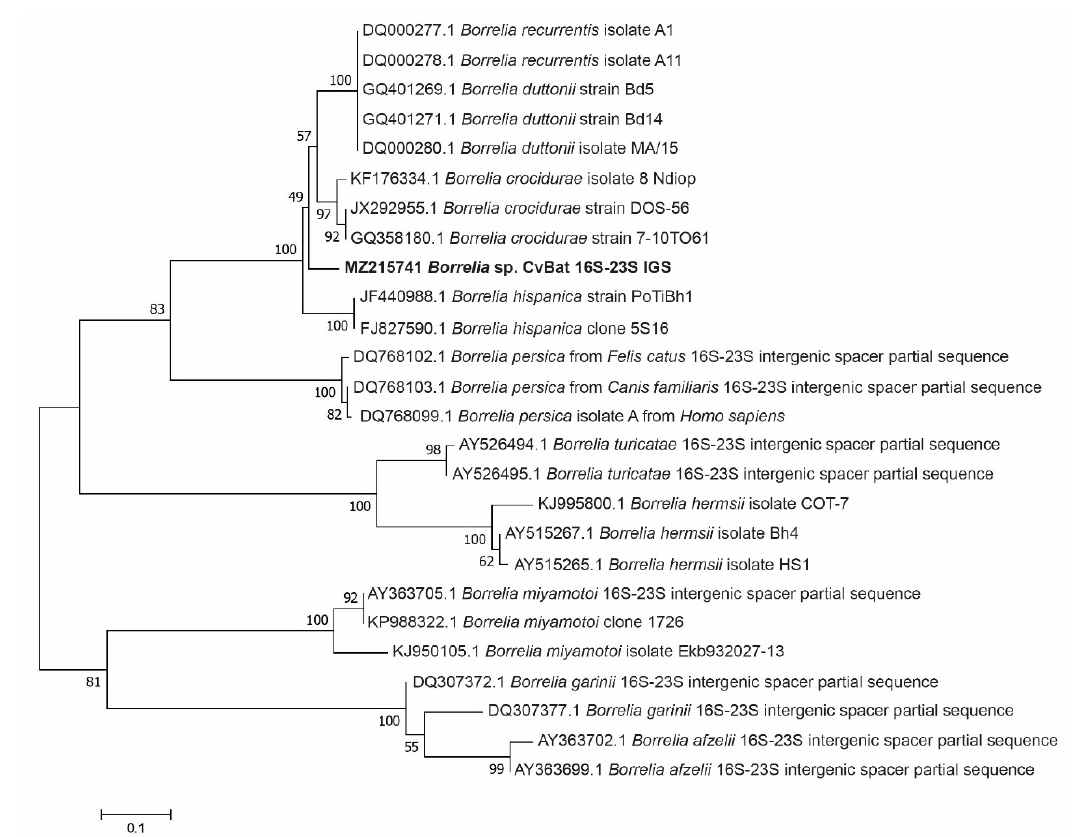
Microorganisms 2021 , 9 , x FOR PEER REVIEW Figure 2. Phylogenetic tree based on 16S-23S intergenic spacer region sequences of Borrelia species. Sequences detected in our study (‘MZ215741 Borrelia sp. CvBat 16S-23S IGS’, n = 11) are highlighted in bold.